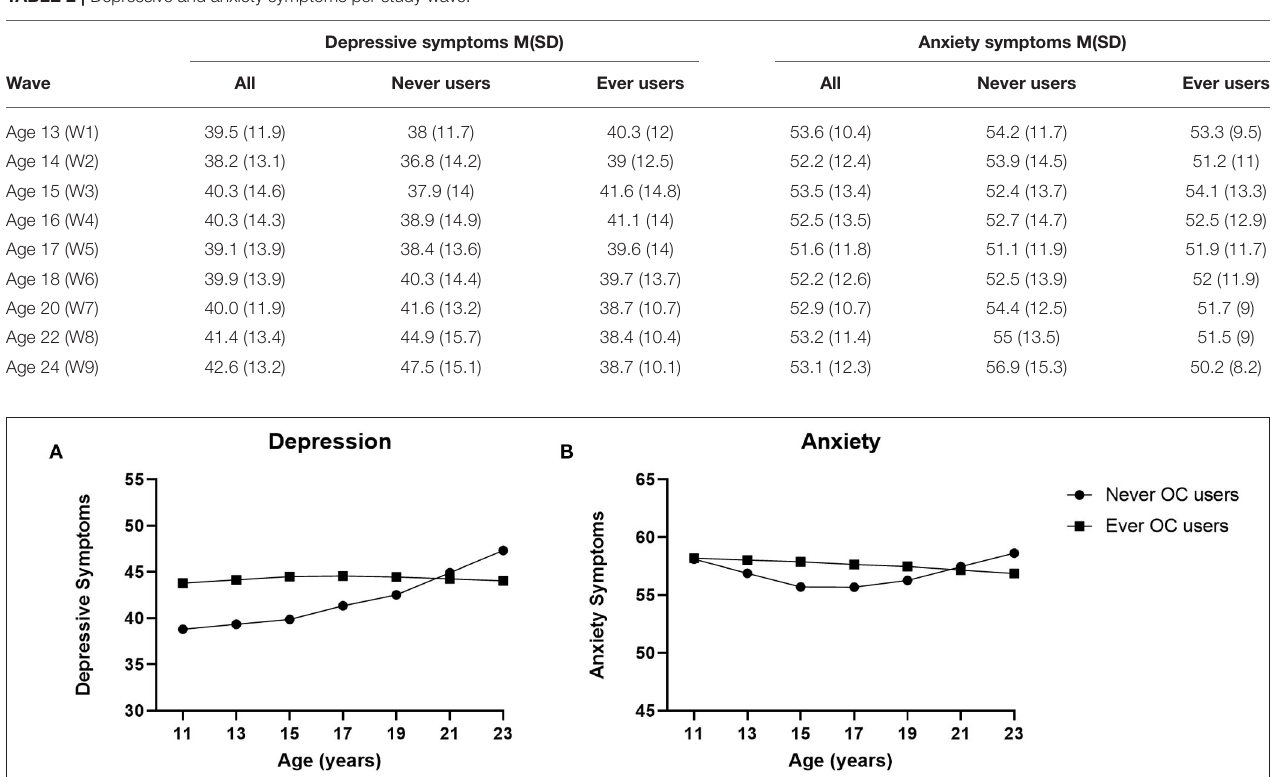
FIGURE 1 | Oral Contraceptive (OC) use and anxiety and depression modeled symptom trajectories. Growth curve models for the depressive and anxiety symptoms for never users of oral contraceptives (OCs) and ever users of OCs. (A) In late adolescence depression scores increased significantly for never users, whereas OC users showed stable depression scores throughout adolescence. (B) An increase in anxiety symptoms toward late adolescence was significant only for never users of OCs, with stable levels of anxiety symptoms for OC users. Means are adjusted for romantic relationships, sexual debut, education level, religion, smoking history, alcohol use, and drug